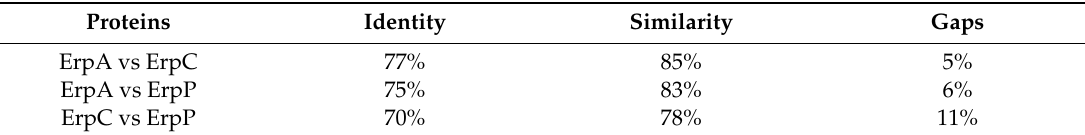
Table 3. Clustal Omega (version 1.2.4) alignment identity, similarity and gaps for Erp amino acid sequences.